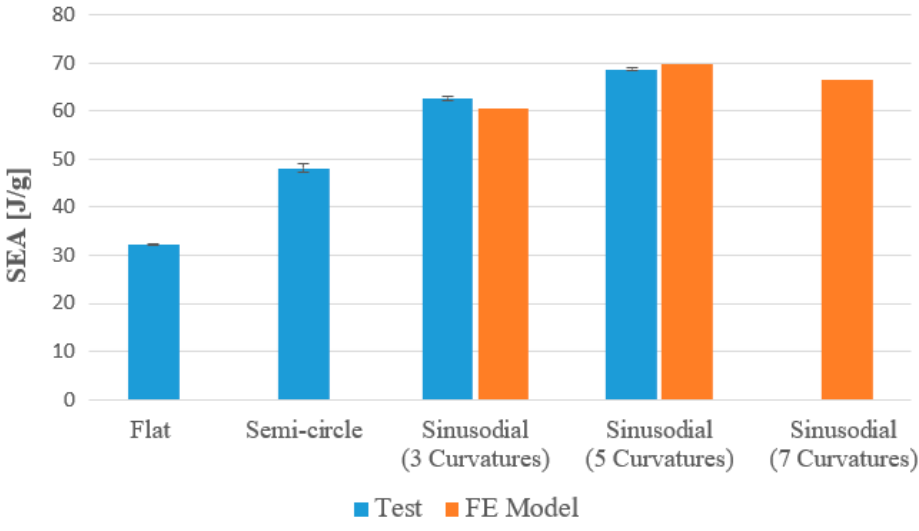
Figure 21. The overall comparison of SEA values from flat plates to complex structures.